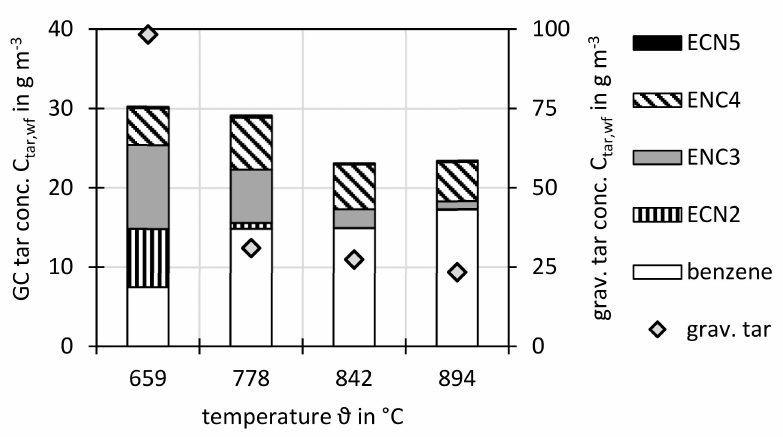
Figure 7. Gravimetric and GC tar concentrations on dry, N 2 -free and STP basis at different gasifier temperatures.